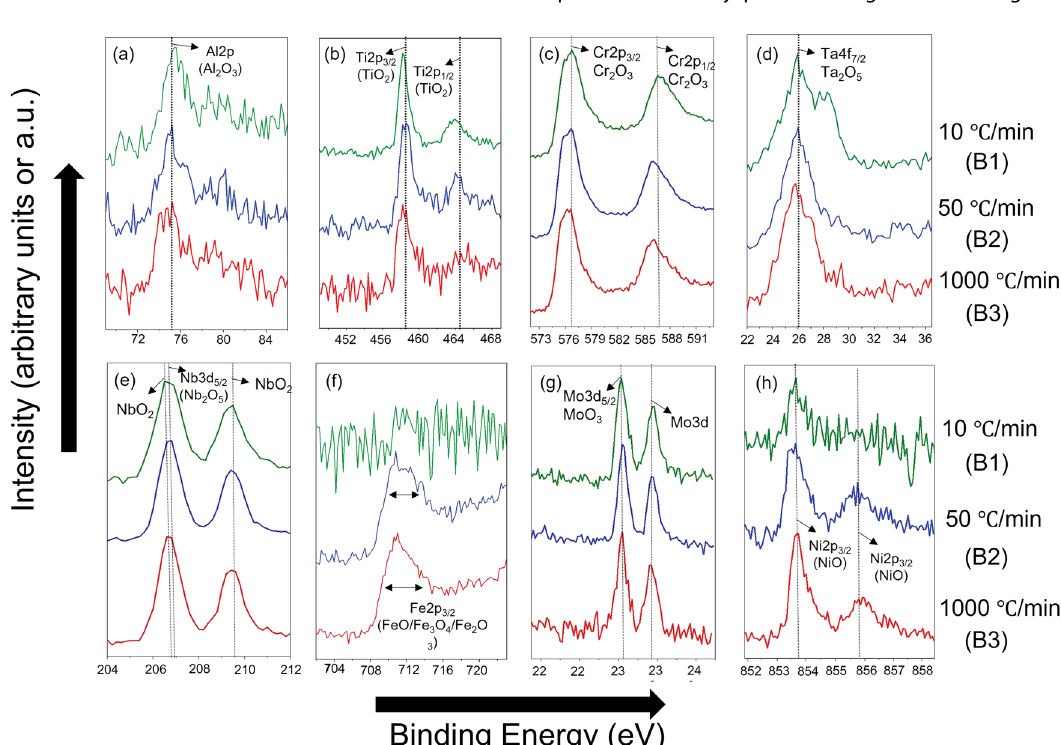
Fig. 4 XPS spectral analysis of isothermally treated L-DED fabricated IN718. Spectra corresponding to the component elements a Al, b Ti, c Cr, d Ta, e Nb, f Fe, g Mo, and h Ni.